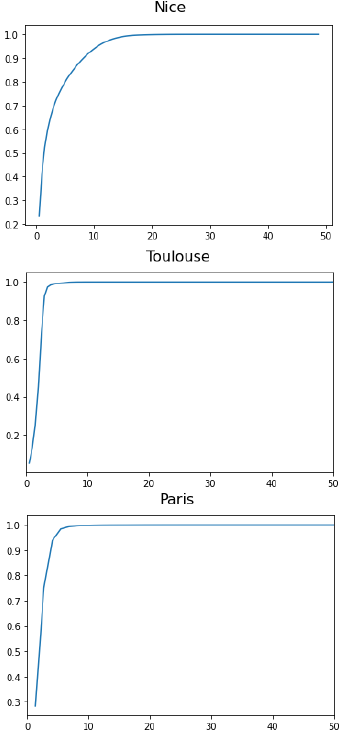
Figure 14. Top: Nice CDF in meter, Middle: Toulouse CDF in meter, Bottom: Paris CDF in meter.